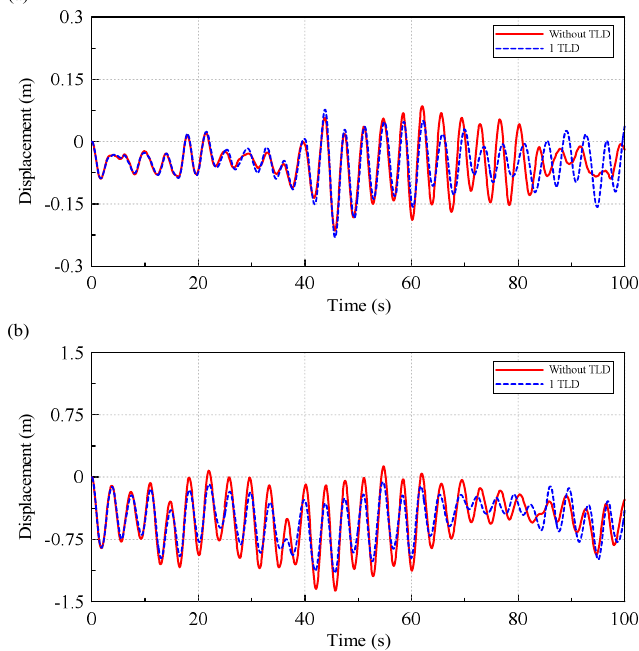
Figure 26. Displacement of RNA for an OWT under the DLC 6.2 condition: ( a ) fore-aft movement; ( b ) side-to-side movement.